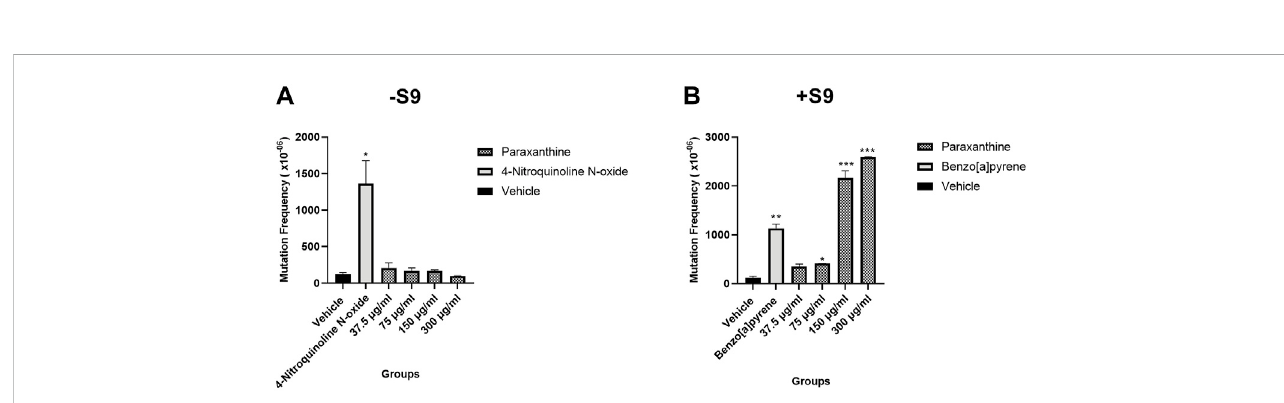
FIGURE 3 Mutant frequency in the (A) absence and (B) presence of S9. Statistically signi fi cant from the vehicle control at p < 0.05 (*), p < 0.01 (**), p < 0.001